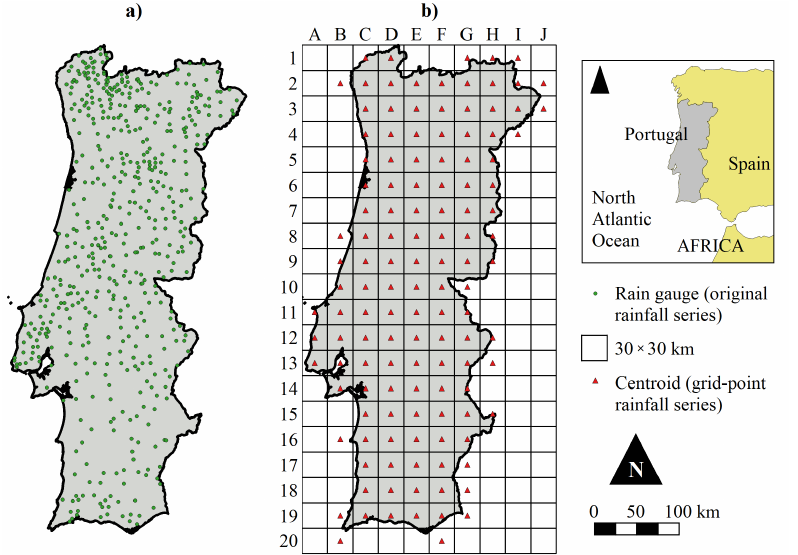
Figure 1. Schematic location of ( a ) the 532 rain gauges, i.e., original rainfall series—from Portela et al. [13]—and ( b ) the constructed mesh with the 126 centroids used for the rainfall trend analysis and teleconnection. Centroids’ coordinate referencing system: WGSM84, UTM zone 29 N; for instance, in metres C1 (527908 and 4652269) and F20 (617908 and 4082269). The grid-point rainfall series were based on the Inverse Distance to a Power gridding method with an exponent of two, IDW2 [26], applied to monthly data from the 532 rain gauges aforementioned. This popular interpolation method has been used in many en- vironmental applications—, e.g., Stahl et al. [27], Tveito et al. [28]. The grid cell size of 30 × 30 km (Figure 1b) was set based on the typical grid lengths implemented by the World Meteorological Organization (WMO) for numerical weather prediction (NWP) systems [29].